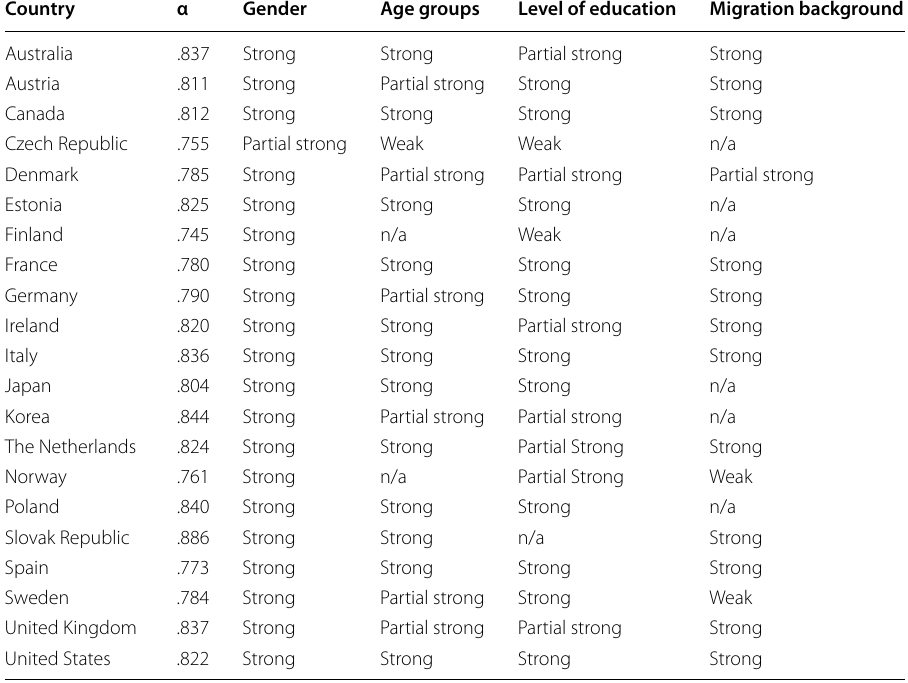
Table 2 Overview of the internal consistency of the scale and the highest level of meas- urement invariance per country and grouping variable Country α